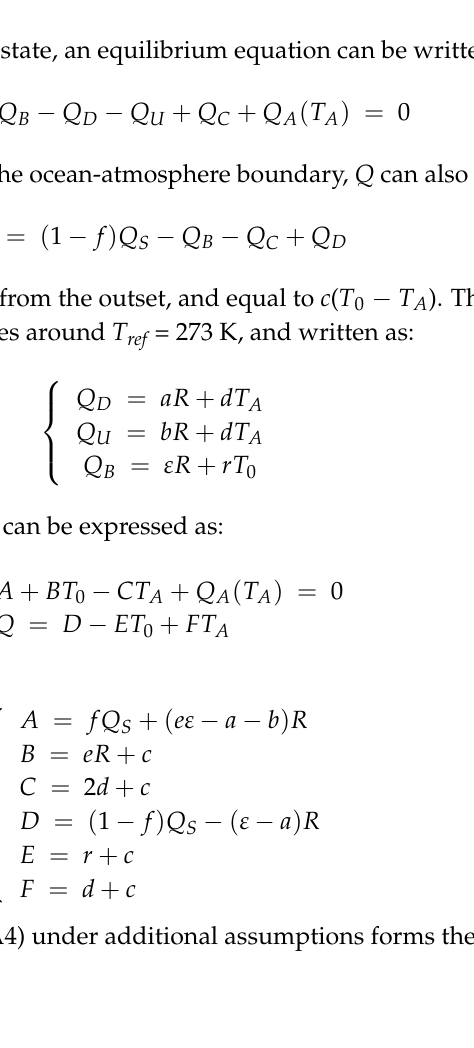
Figure A1. Local atmospheric heat fluxes considered in Rahmstorf and Willebrand [20].